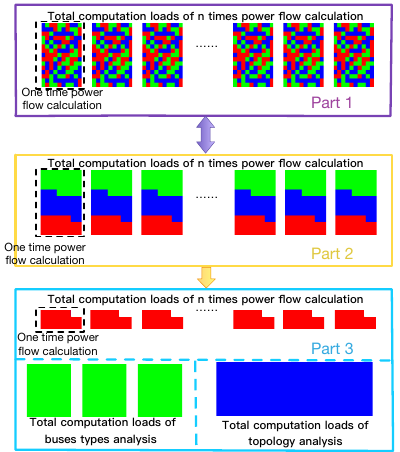
Figure 4. Schematic diagram of the proposed technique idea.